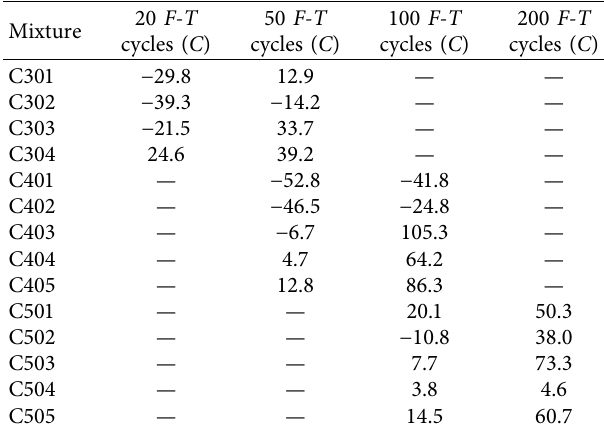
Figure 4: Relationship between charge passed after freezing and thawing and aggregate concentration. Table 3: Relative change of charge passed after F - T